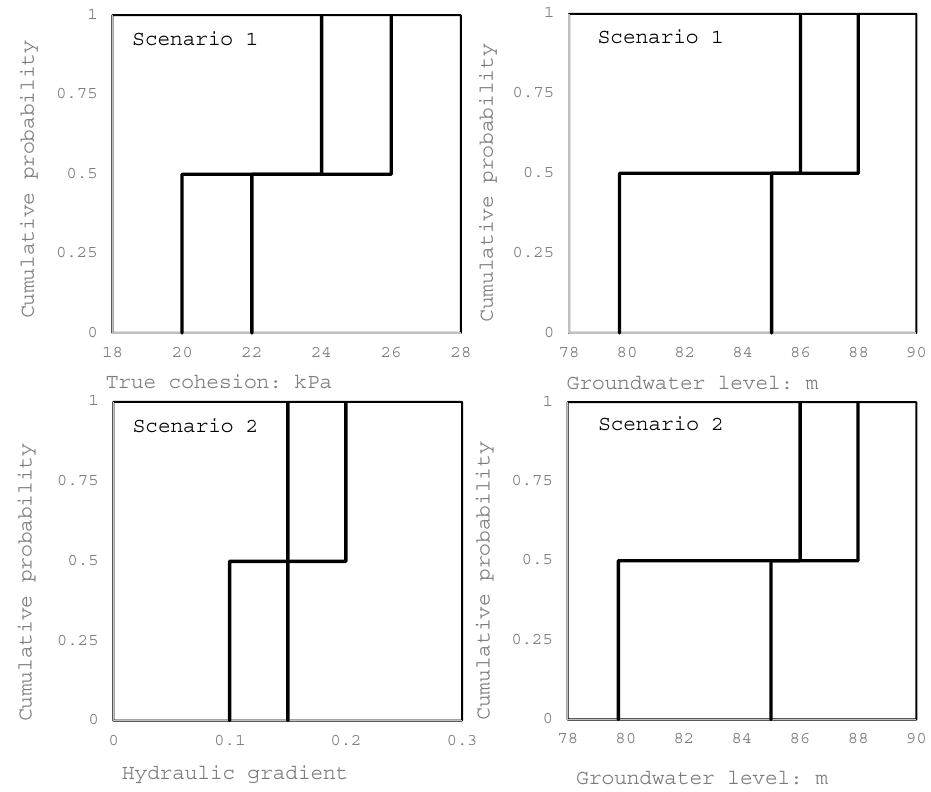
Figure 2. Range of input variables in RS p -Box; scenario 1: Stochastically dependent variables: Water level and cohesion, scenario 2: Stochastically independent variables: Water level and flow rate.